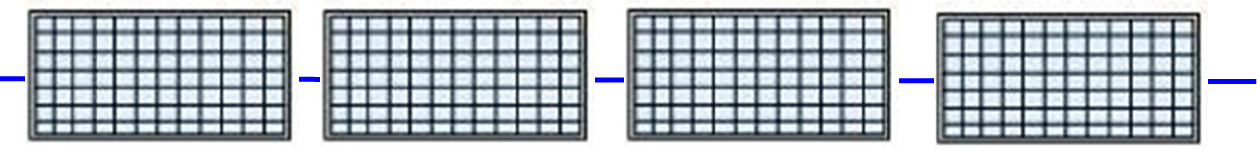
Figure 4. Solar voltaic panels in a series configuration [9].